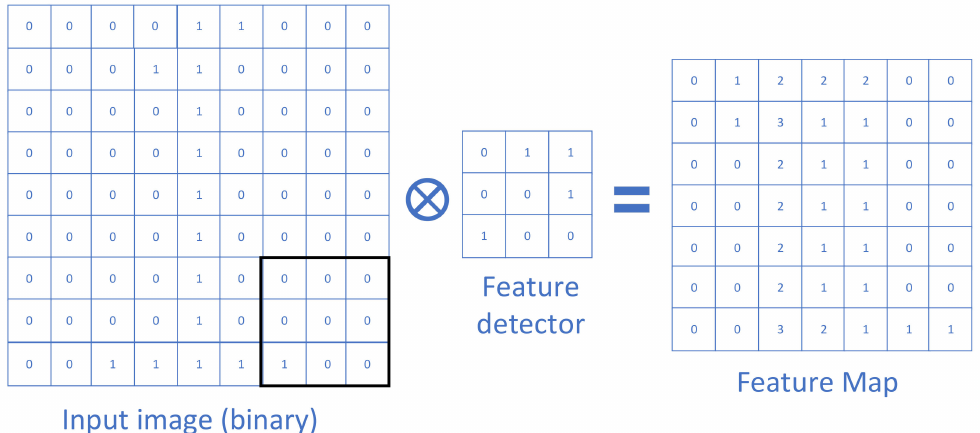
Figure 5. Binary conversion of feature map